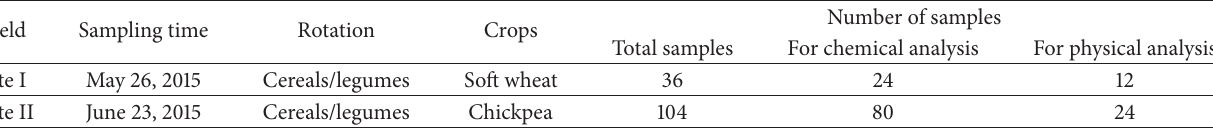
Table 2: Summary of soil samples collected from two